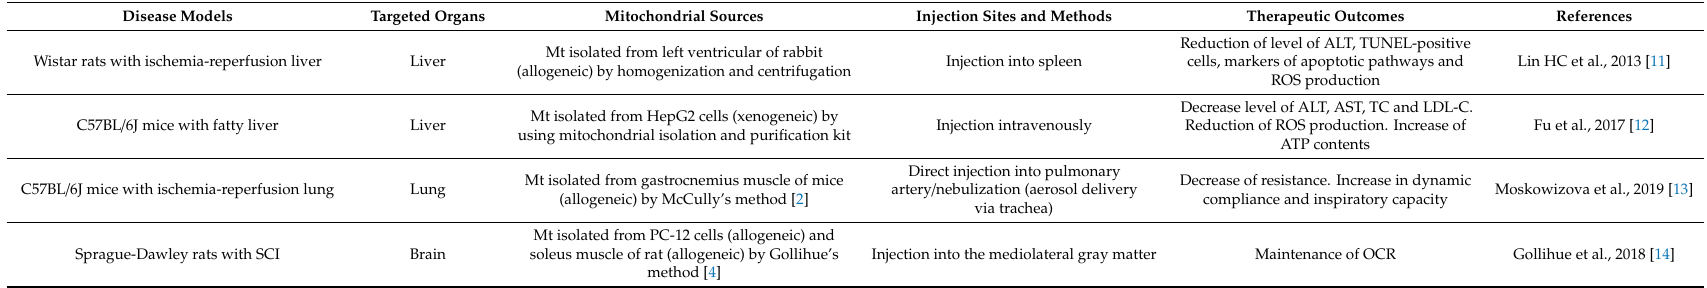
Table 2. Research reports of mitochondrial transplantation in the liver, lung, and